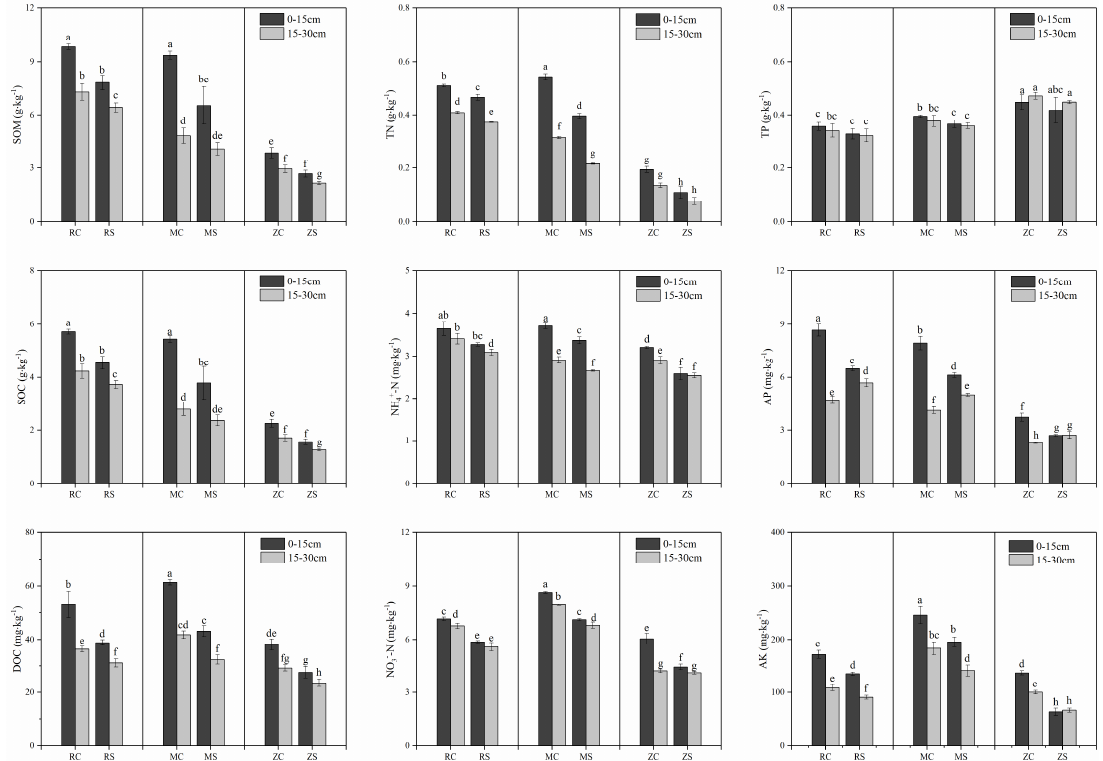
Figure 3. Changes in soil nutrients in the control and subsidence areas of three coal mines. Different lowercase letters indicate significant di ff erences at 0.05 ( p < 0.05) levels. SOM: soil organic lowercase letters indicate significant differences at 0.05 ( p < 0.05) levels. SOM: soil organic matter;